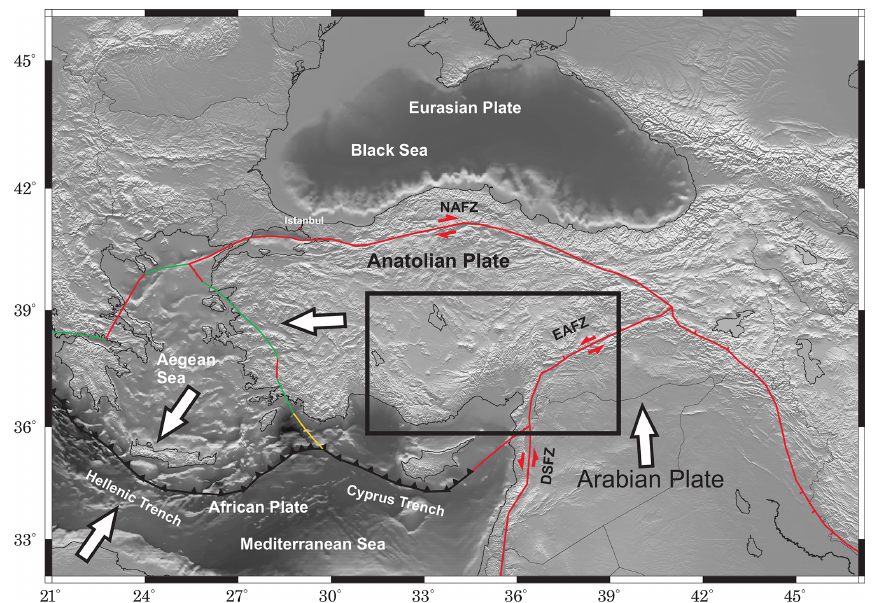
Figure 1. Major tectonic features of Turkey and the adjacent areas. The plate boundary data used here are taken from Bird (2003). Subduction zones are black, continental transform faults are red, continental rift boundaries are green, and spreading ridge boundaries are yellow. NAFZ, EAFZ, and DSFZ are the North Anatolian Fault, East Anatolian Fault, and the Dead Sea Fault, respectively.